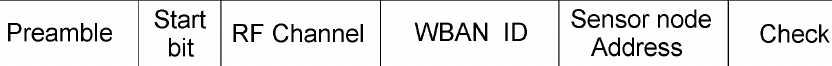
Figure 6. whMAC wake up packet: OOK modulated